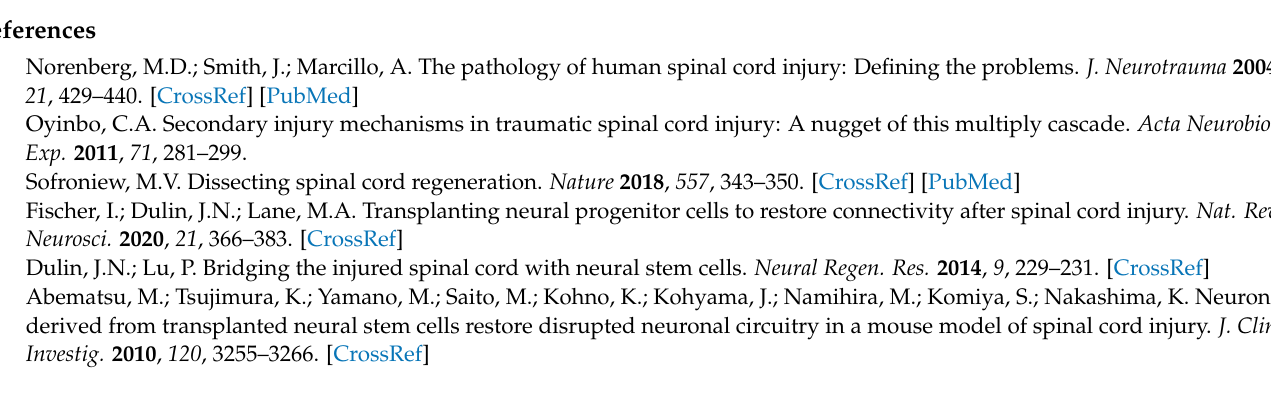
NSC, Figure S2: Catwalk gait analysis, Figure S3: Long-term survival of stem cells transplants in the injured spinal cord, Figure S4: Individual iPSC-NSC and MSC transplantation increases motoneuron preservation, Table S1: In vitro effects of 24 h 10 µ M PA-C treatment on genes involved in neurogenesis, cell cycle, and apoptosis in